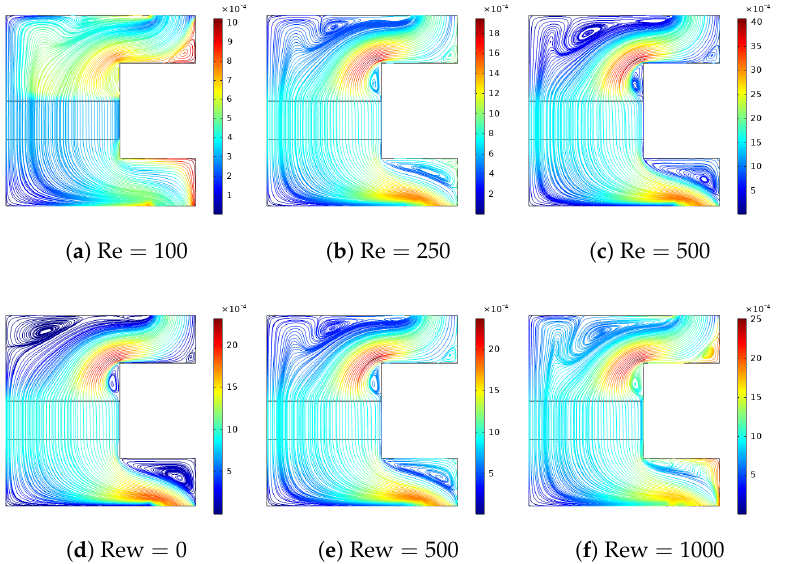
Figure 5. Impacts of fluid stream Re (Rew = 500, ( a )–( c )) and rotational Re numbers (Re = 300, ( d )–( f )) on the flow pattern distributions within the vented U-shaped cavity ( di = 0.25 L 1, L 0 = 0.6 L 1, yp = 0.1 H, and NC =